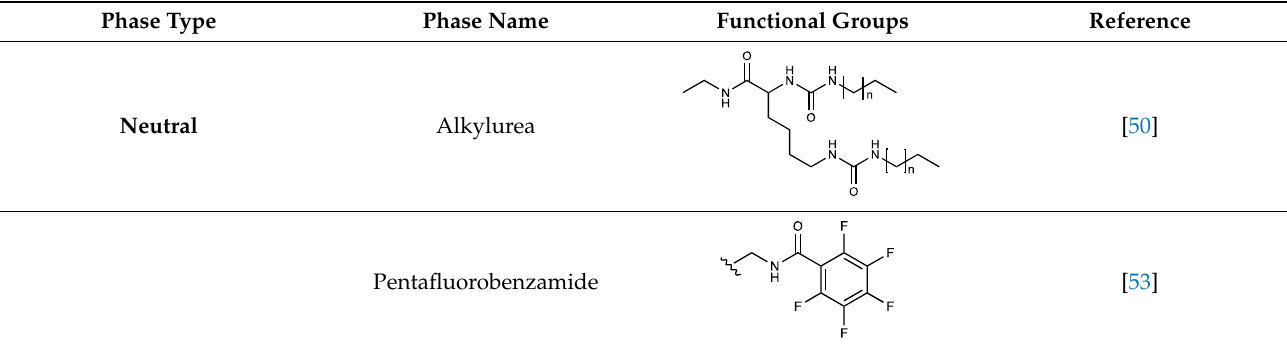
Table 2. Non-commercial stationary phases (in alphabetical order).